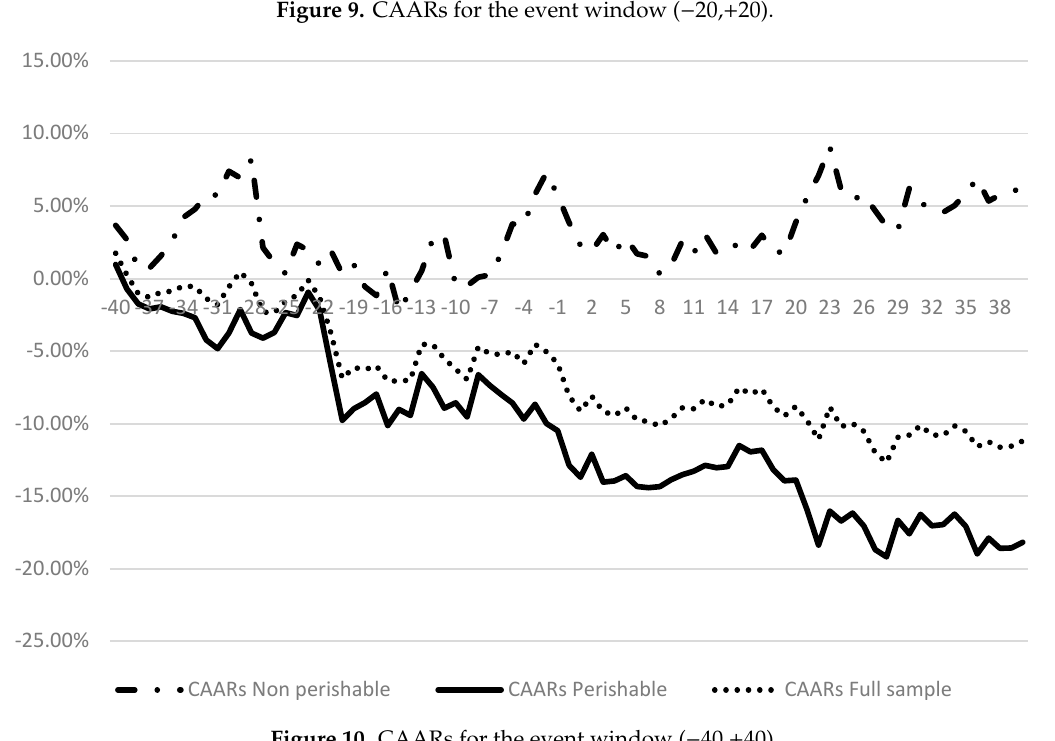
Figure 10. CAARs for the event window ( − 40,+40).